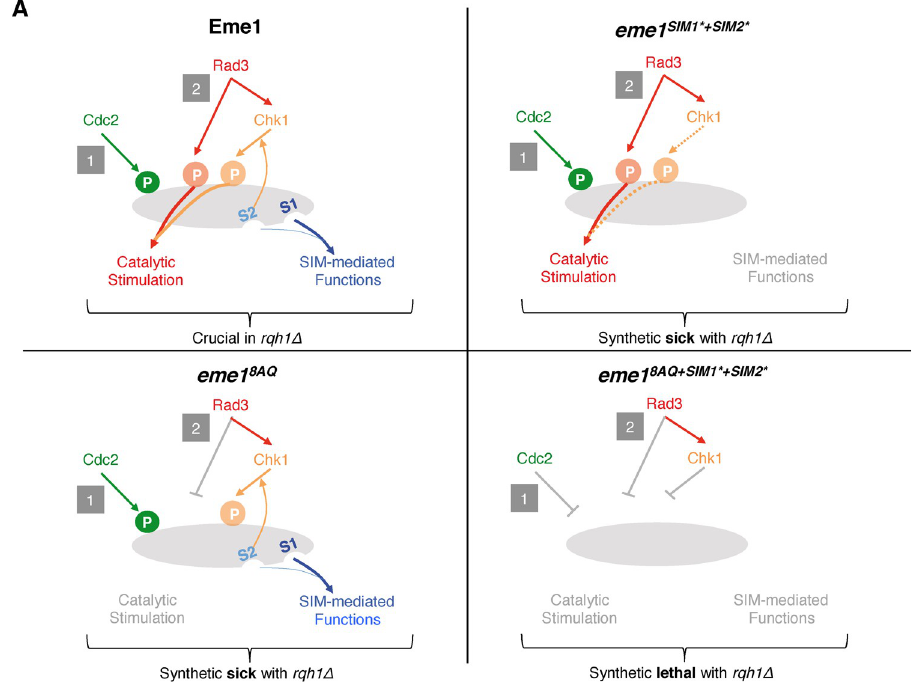
Fig 8. Model for the synthetic lethality resulting from combined loss of Eme1 phosphorylation and SUMO- binding properties in absence of Rqh1 BLM . See text for details.